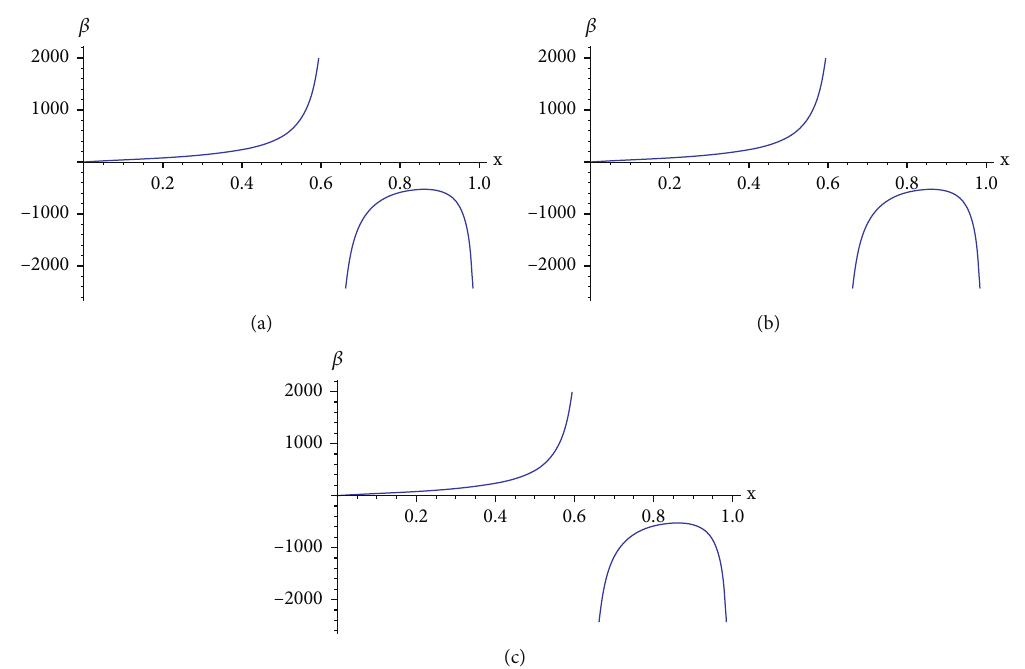
= 0 : 03 , (b) for ϕ 2 = 0 : 04 , and (c) for ϕ 2 + +